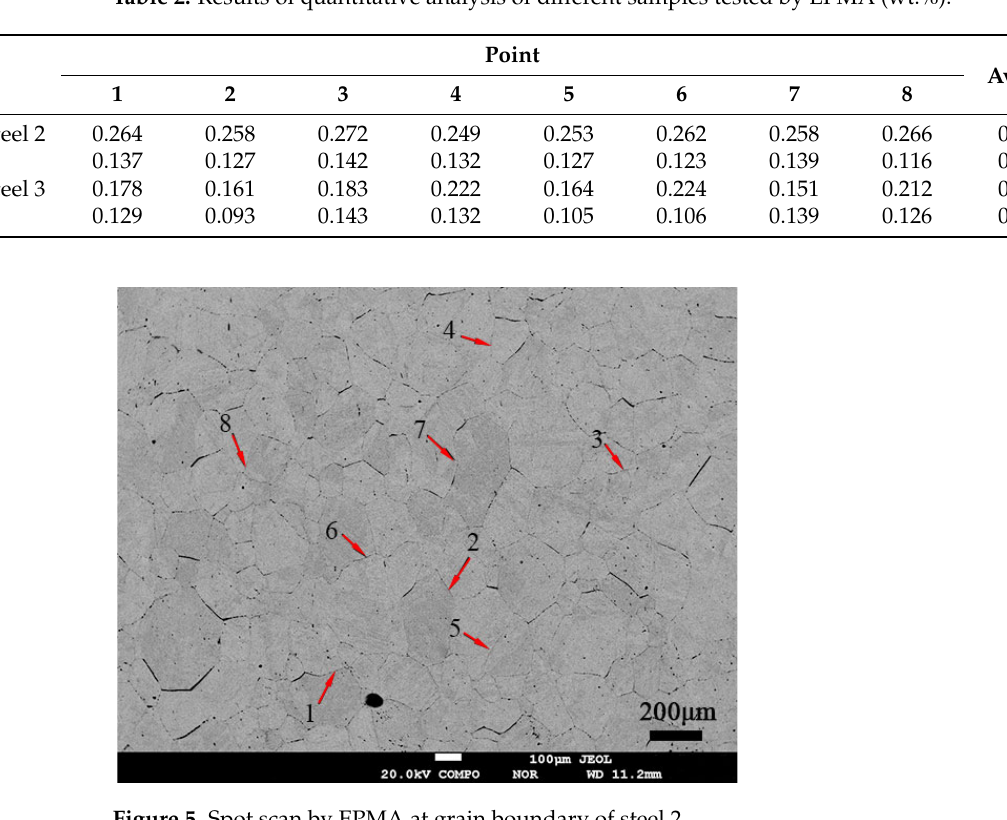
Table 2. Results of quantitative analysis of different samples tested by EPMA (wt.%).